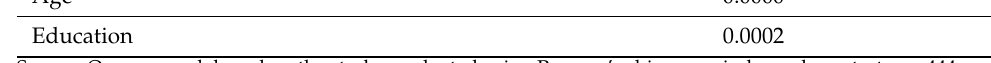
Table 6. Assessment of the appropriateness of centralizing decarbonization funds from the perspec-